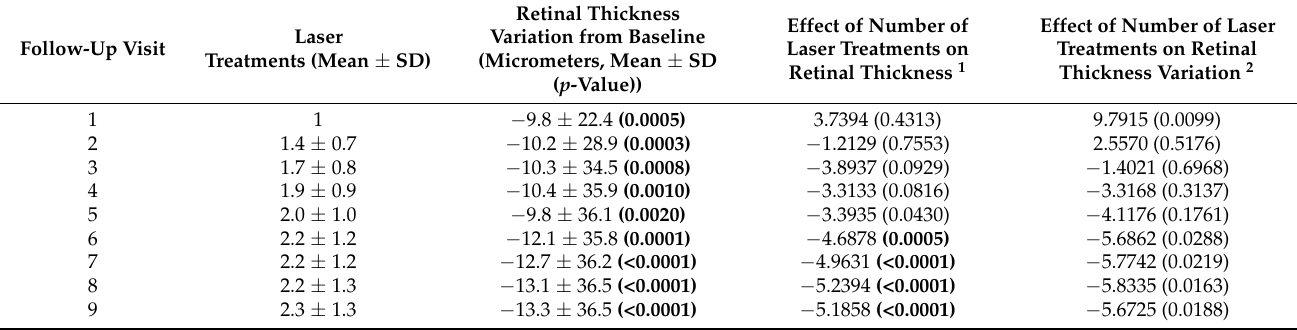
Table 4. Morphologic results at follow-up intervals: thickest sector at